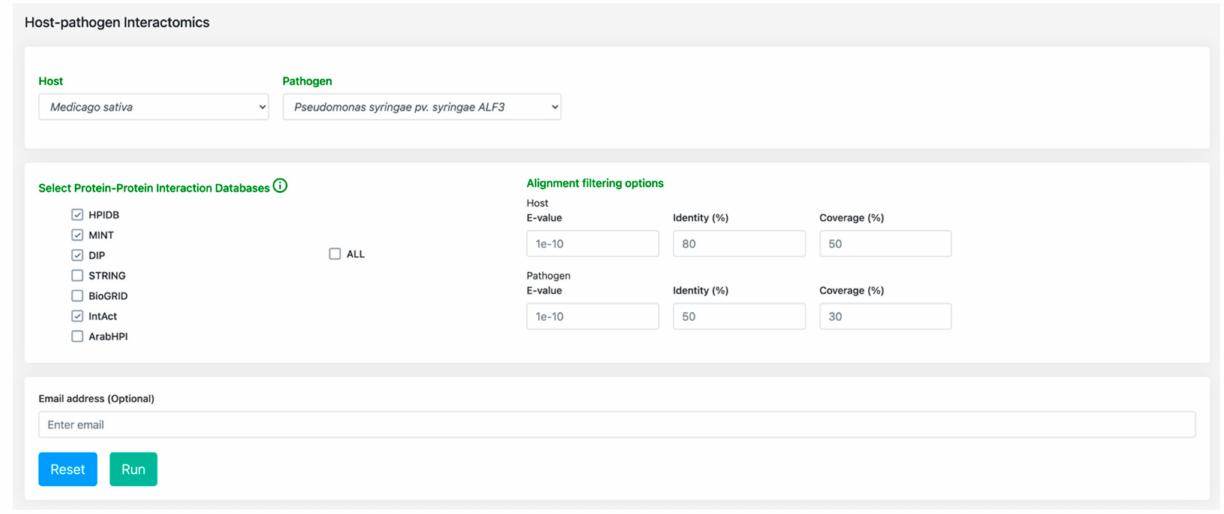
Figure 2. Interface of the host-pathogen interactome